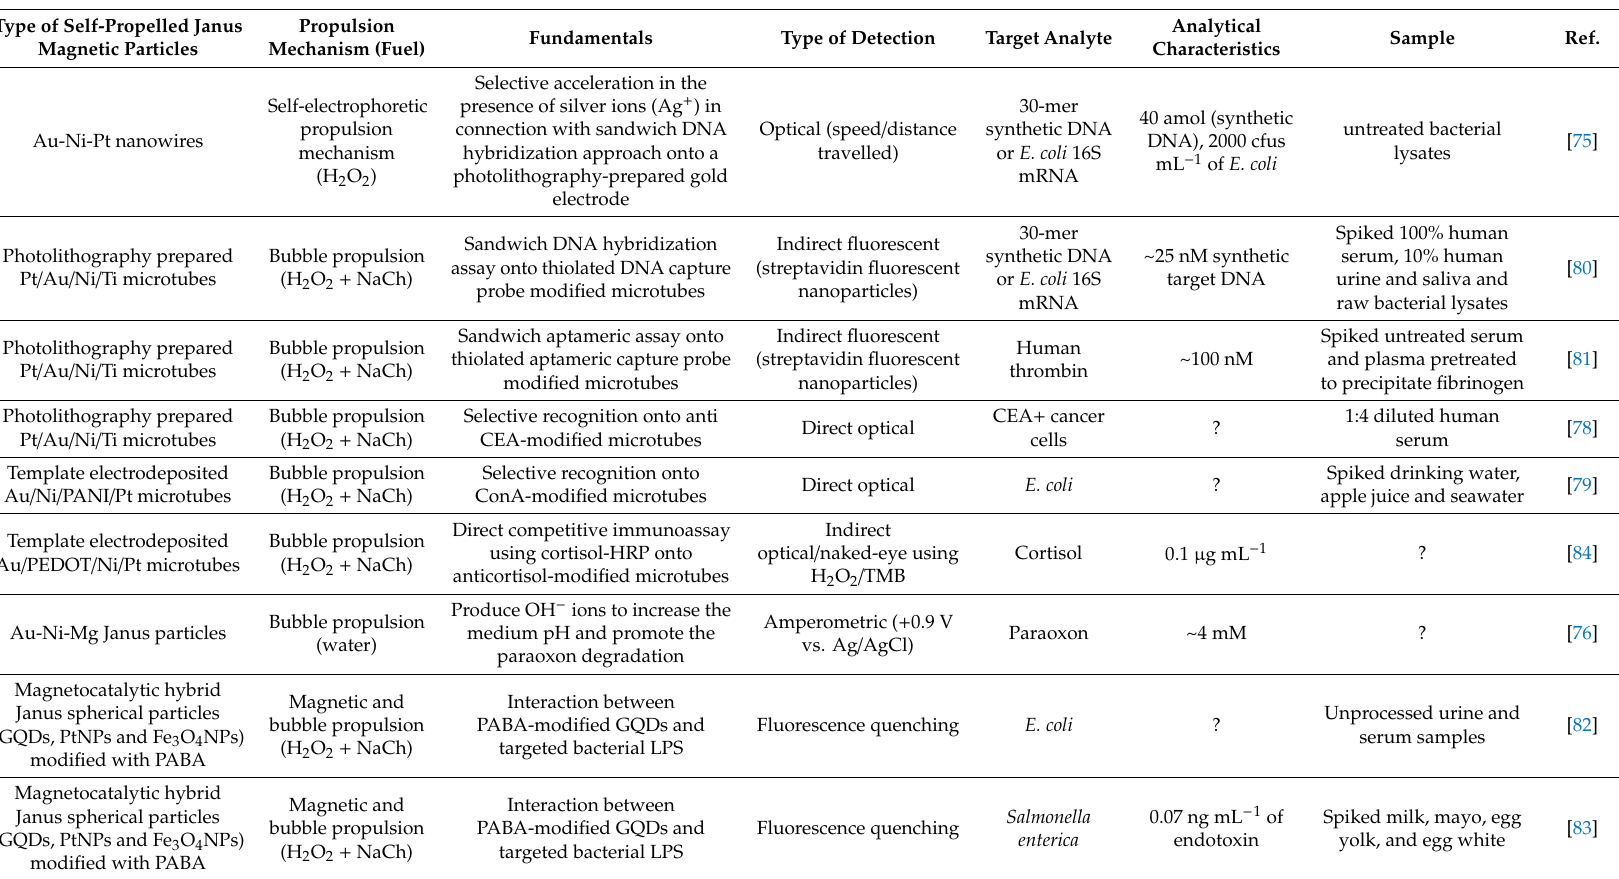
Table 3. Self-propelled Janus magnetic particles for